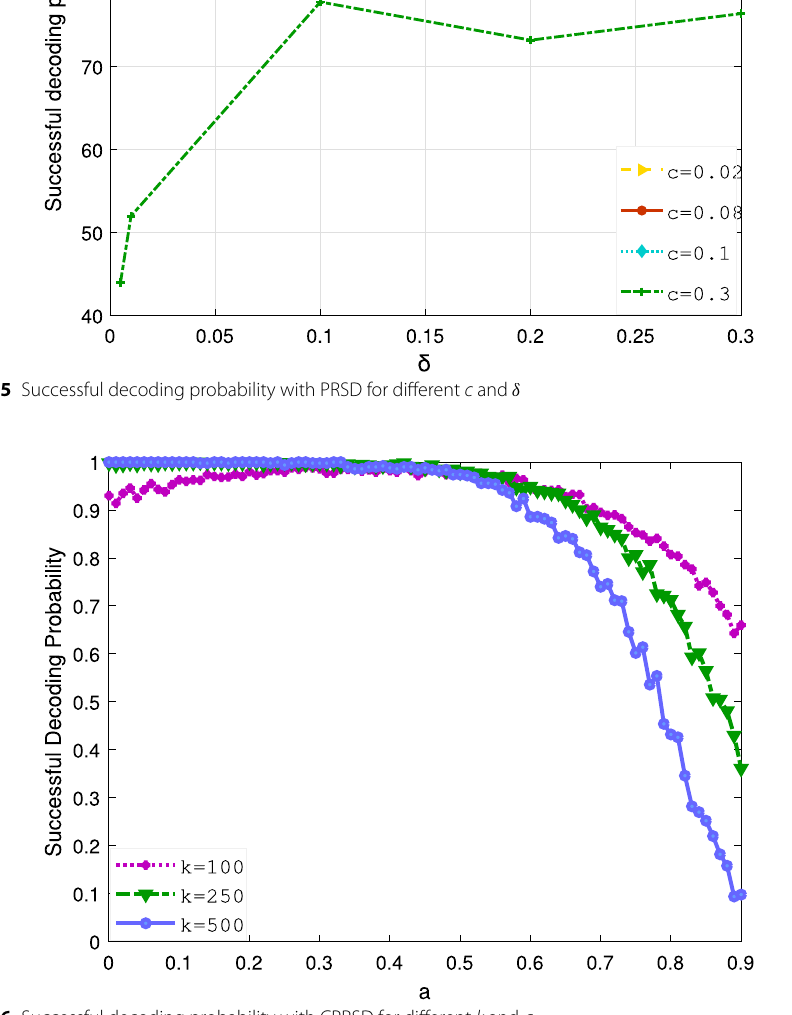
Fig. 6 Successful decoding probability with CPRSD for different k and